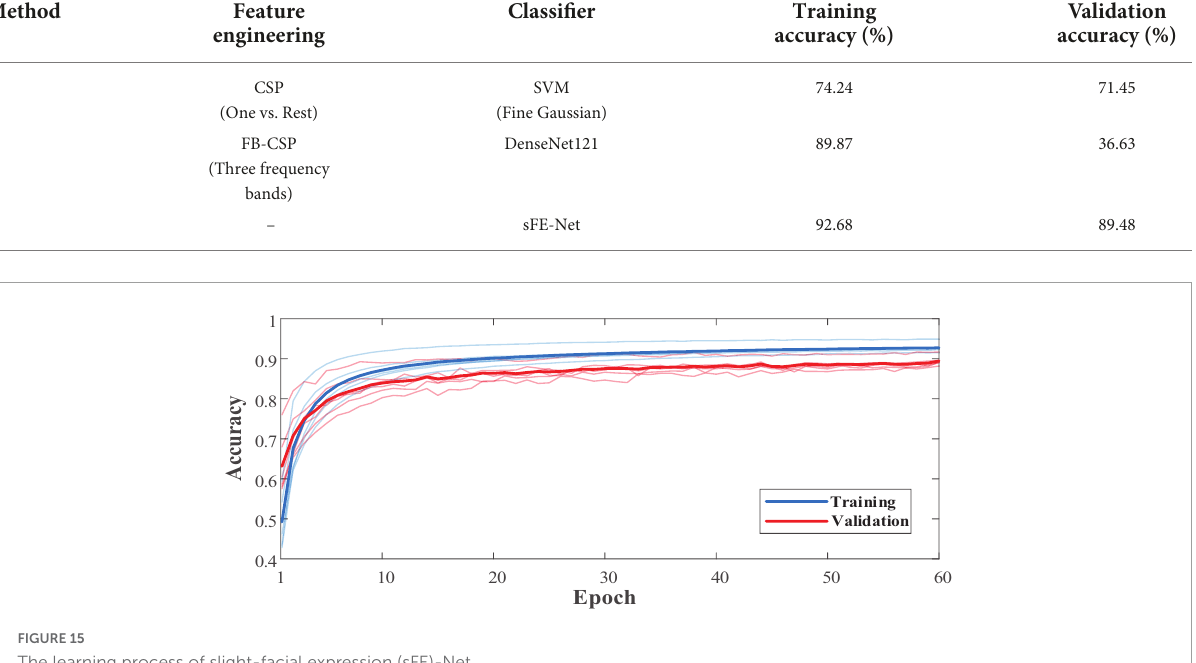
FIGURE15 The learning process of slight-facial expression (sFE)-Net.